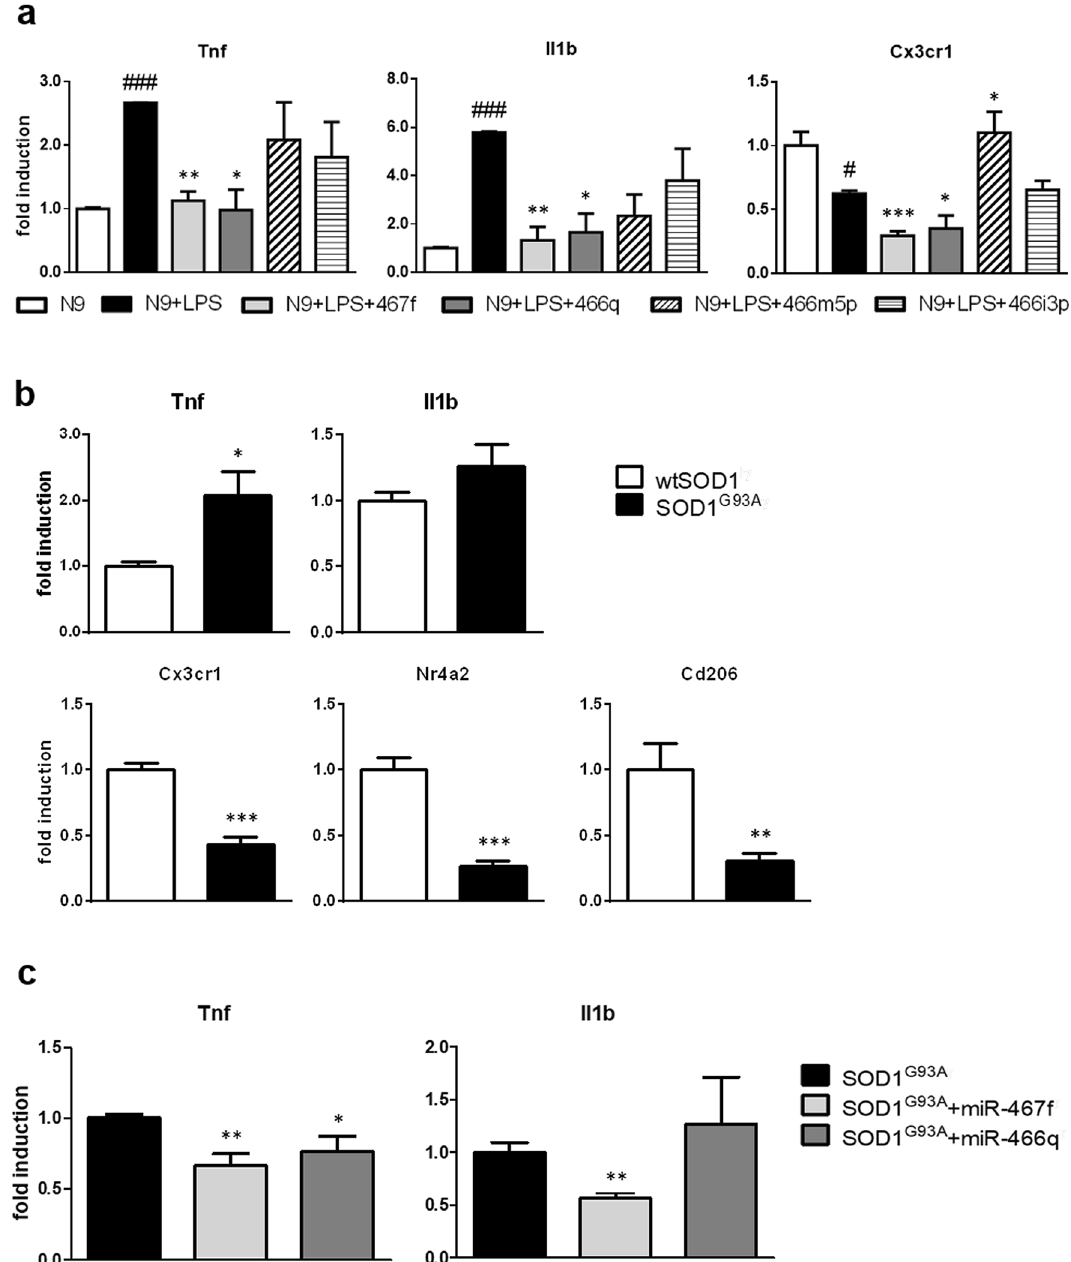
Figure 3. Transfection with specific miRNA mimics induces changes in the pro-inflammatory phenotype of activated microglia. ( a ) RT-PCR analysis of markers relevant to microglia activation in LPS-activated N9 cells. N9 cells were transfected for 48 h with synthetic mimics of the four miRNAs as indicated in “Methods”. # P < 0.05 (Cx3cr1), ### P < 0.001 (Tnf; Il1b): N9 vs N9 + LPS; * P < 0.05, ** P < 0.01, *** P < 0.001: N9 + LPS vs N9 + LPS transfected with specific miRNA (N9 + LPS + miRNA). ( b ) RT-PCR quantification of pro-inflammatory (Tnf and Il1b) and anti-inflammatory genes (Cx3cr1, Nr4a2, Cd206) in wtSOD1 and SOD1 G93A primary microglia. * P < 0.05, ** P < 0.01, *** P < 0.001. ( c ) RT-PCR analysis of markers relevant to microglia activation in SOD1 G93A primary microglia. SOD1 G93A microglia were transfected overnight with synthetic mimics of the four miRNAs as indicated in “Methods”. Data are presented as mean ± SEM of 3 independent experiments conducted in